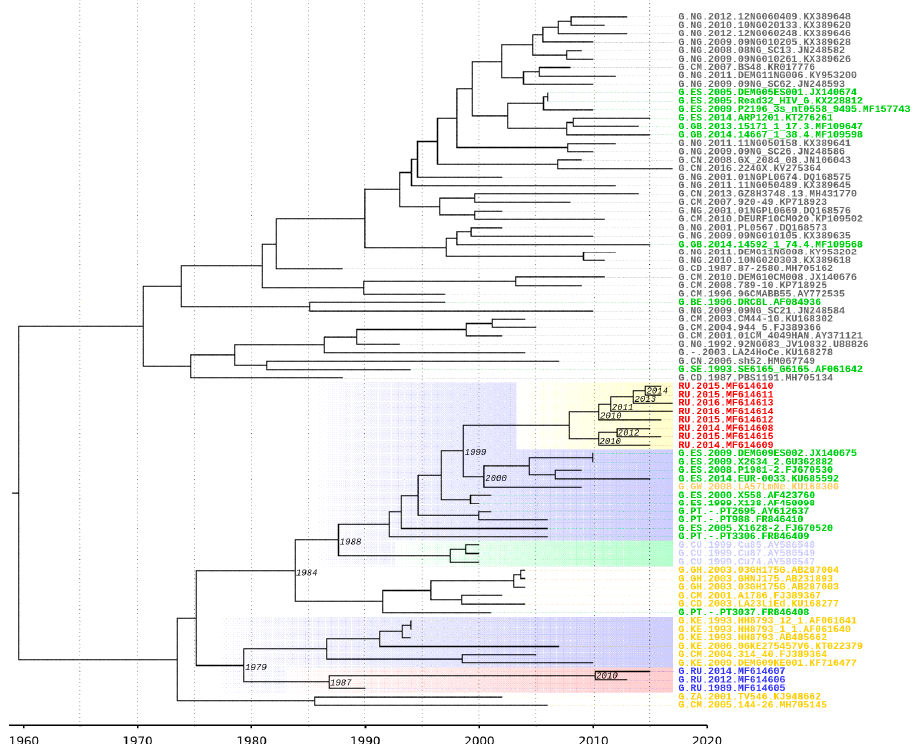
Figure 6. Dated Bayesian phylogenetic tree of subtype G and new BG recombinants. The BG recombinants are highlighted in red, the G subtype from patients from the nosocomial outbreak is highlighted in blue, samples from Europe are highlighted in green and samples from Africa are highlighted in yellow and black. The branch from Elista outbreak samples is shown in red and the branch from the BG recombinants is shown in yellow. The horizontal scale axis at the bottom corresponds to the calendar year. Nodes of branches contain the average 95% highest posterior density (HPD).